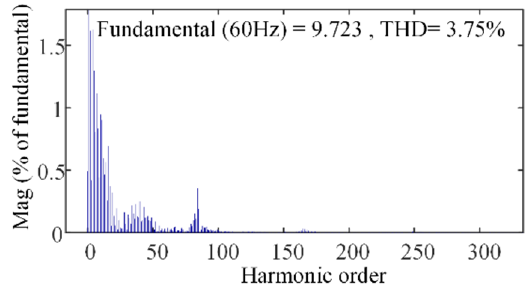
Figure 9. FFT results for rectifier side current.